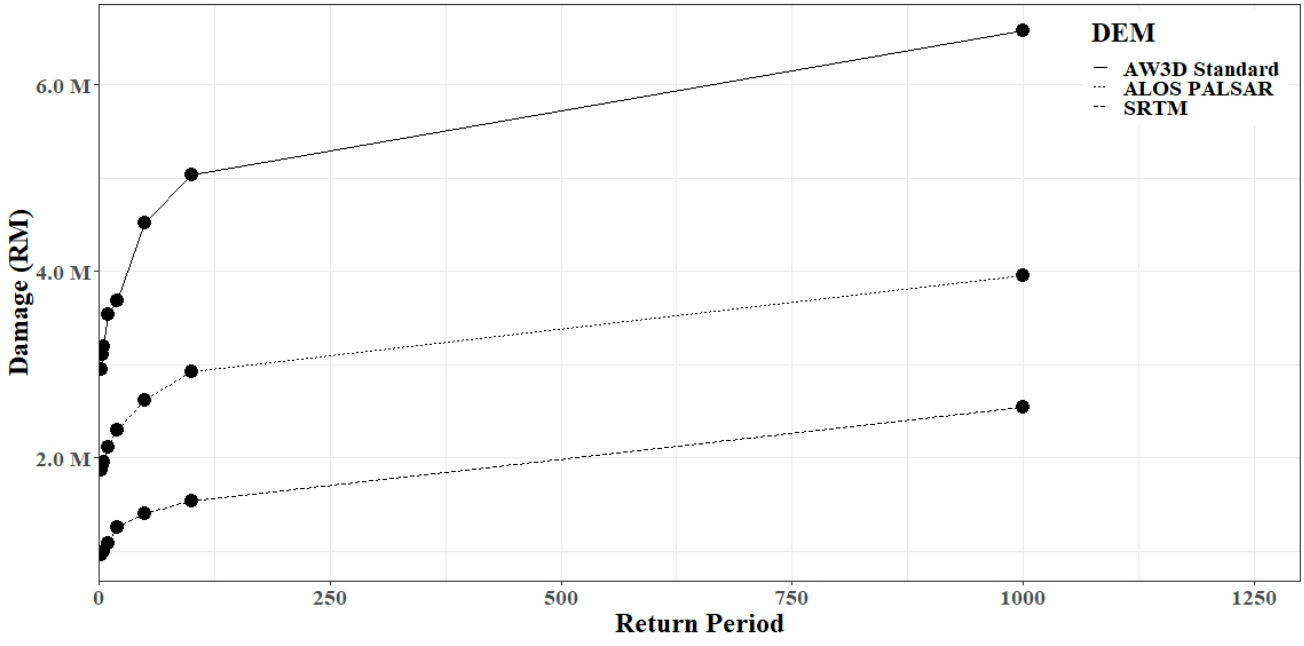
Figure 7. Flood damage estimates for AW3D Standard, ALOS PALSAR and SRTM with interpolation lines. Bullet dots refer to the total damage for each flood event.